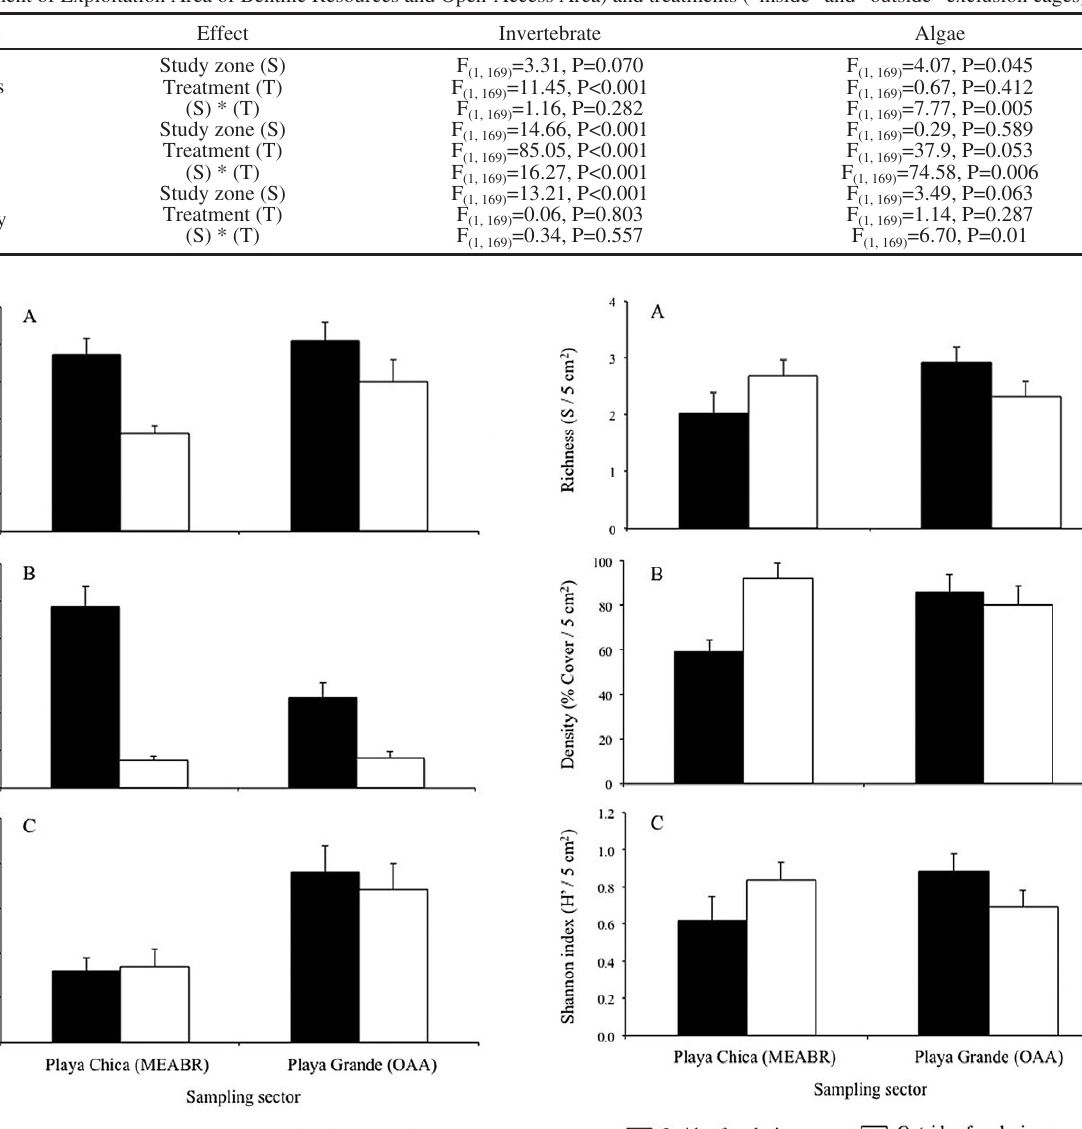
Table 2. – General linear model (two-way analysis of variance) results comparing richness, density and diversity between study zones (Man- agement of Exploitation Area of Benthic Resources and Open-Access Area) and treatments (“inside” and “outside” exclusion cages).